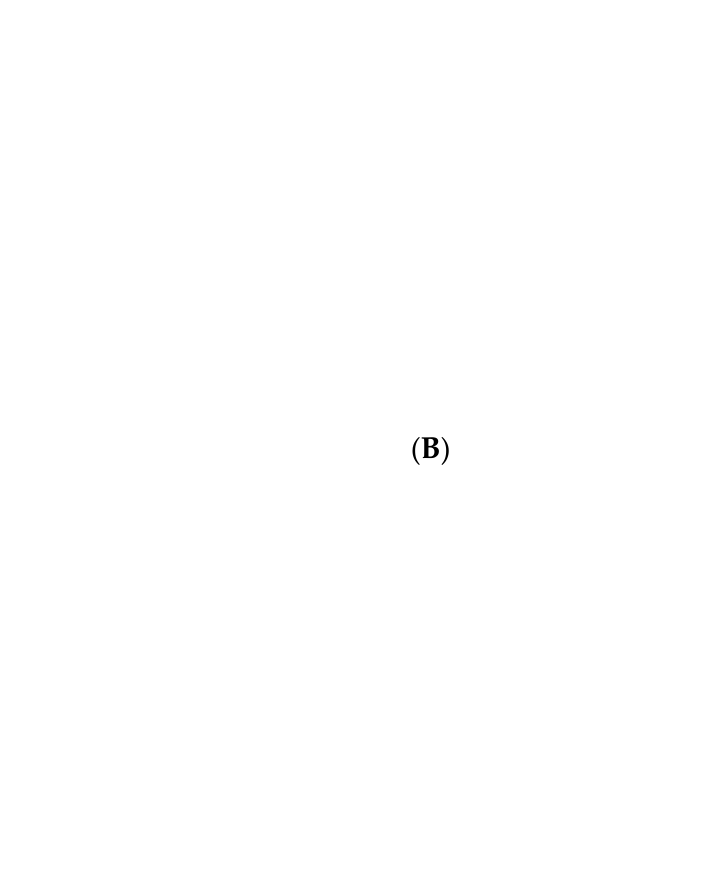
Figure 4. The network of protein–protein interaction. ( A ) The protein–protein interaction network was established by the STRING database. ( B ) The hub genes were selected in this study. The red and yellow color mean the highest to lowest degree among the ten hub genes.